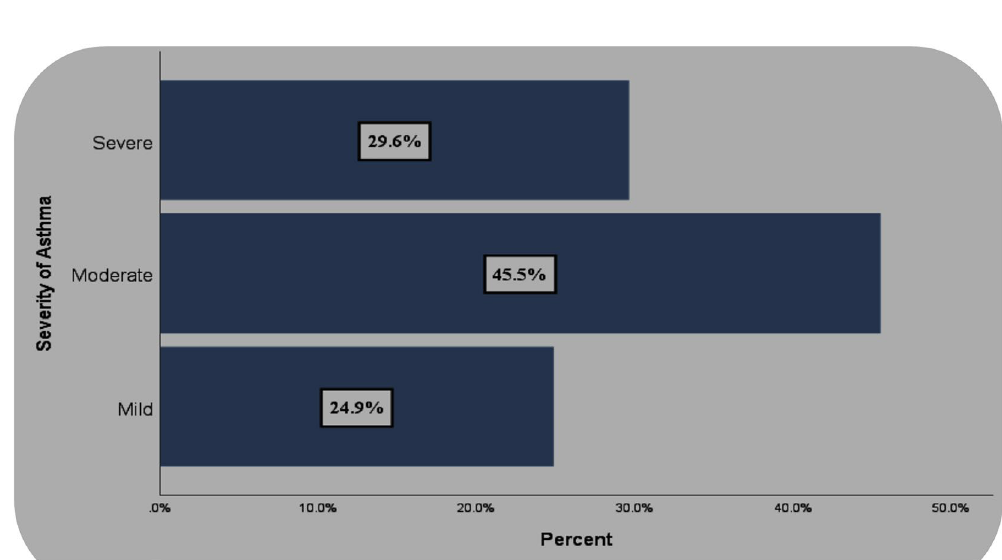
Figure 1. Severity of asthma in adult patients assisted at the Adult Emergency Department of the Jimma Medical Center, Jimma Town, Ethiopia during 25 July, 2021 to 25 August,